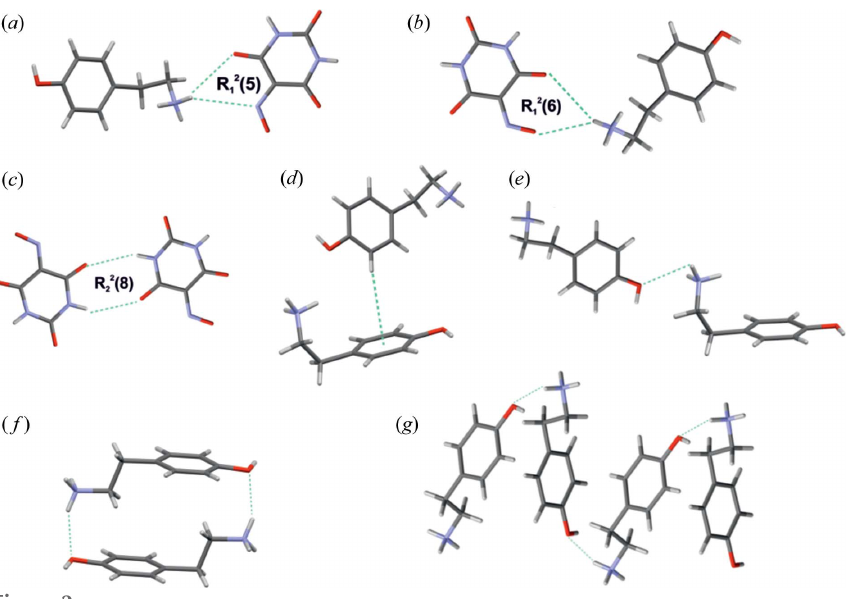
Figure 2 ( a )–( g ) Possible hydrogen-bond motifs to be formed between tyraminium cations and violurate anions. Figure prepared in Mercury 3.10.2 (Macrae et al. , 2008).